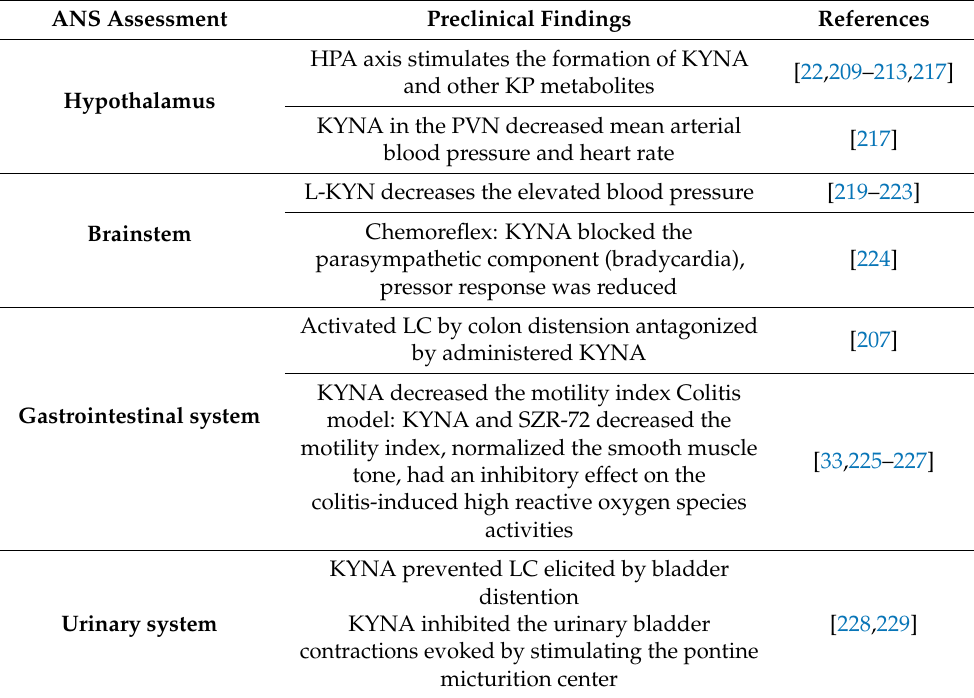
Table 3. The interplay of kynurenines and the autonomic